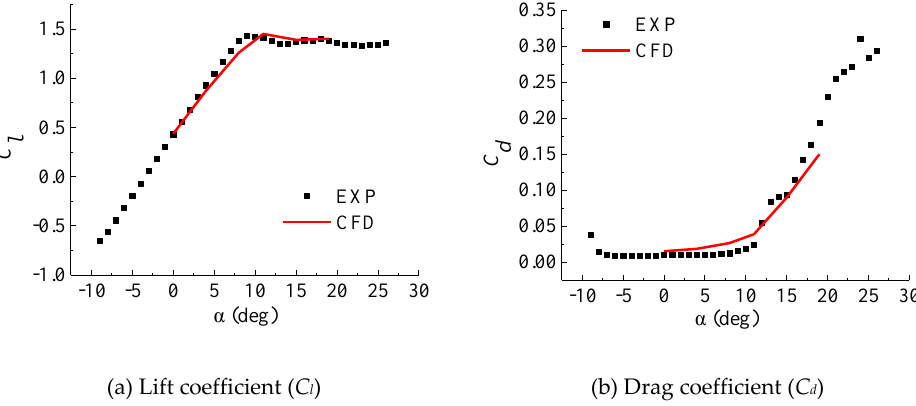
ffi cient curve ( a ), and drag coe ffi cient curve ( b ) of DU93-W-210 airfoil. Figure 9. Lift coefficient curve (a), and drag coefficient curve (b) of DU93-W-210 airfoil Figure 9. Lift coe